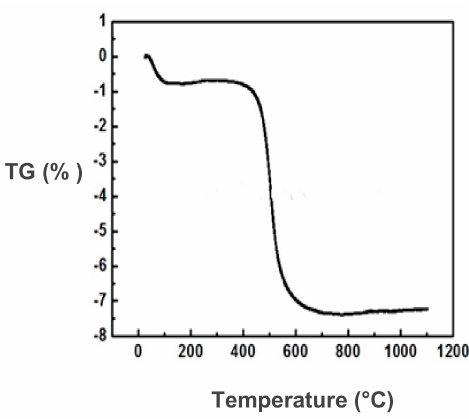
Figure 3. TGA analysis for Tabarka clay.